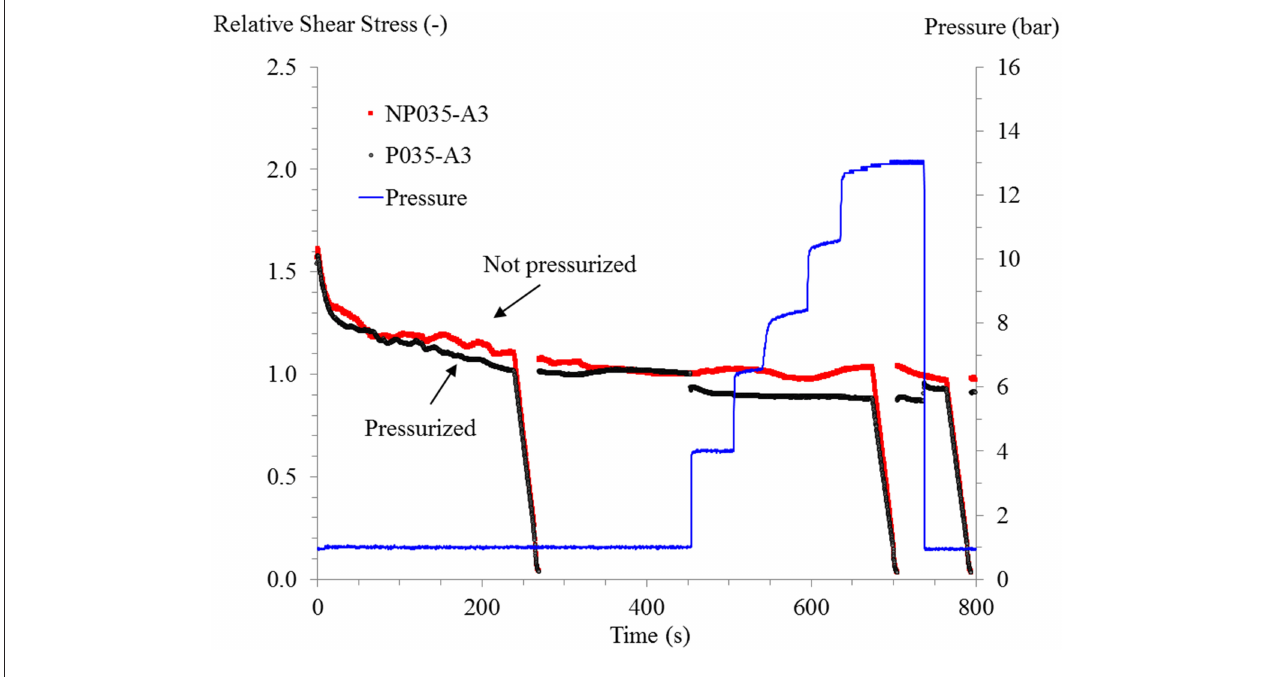
FIGURE 6 | Rheological testing procedure “A” applied on mixture P035-A3.